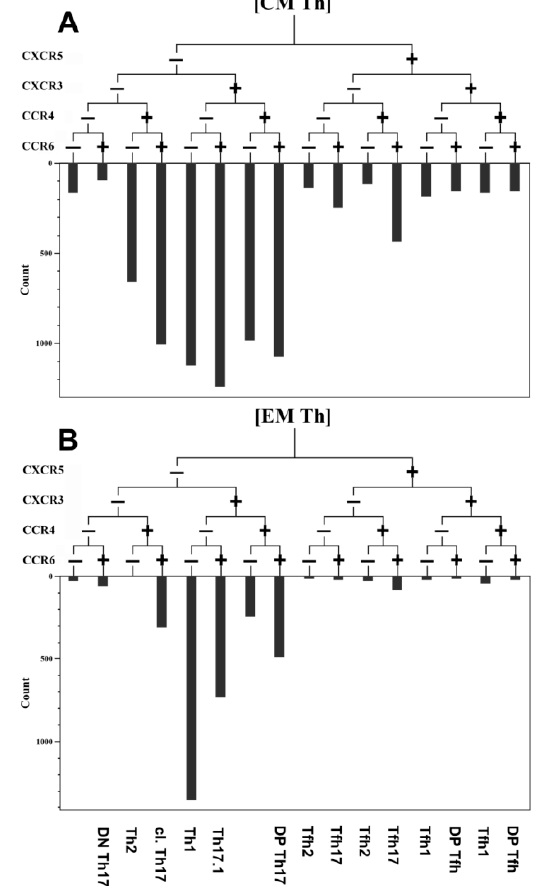
Figure 2. An example of the relative distribution of CM and EM Th cells subsets according to their expression of CXCR5, CXCR3, CCR6, and CCR4 in the healthy donor. ( A ) Central memory Th cells (CM). ( B ) Effector memory Th cells (EM). The frequency histogram below the trees indicates the relative proportion of cells with different patterns of CXCR5, CXCR3, CCR6, and CCR4 and is based on their expression in Th-cell subsets.